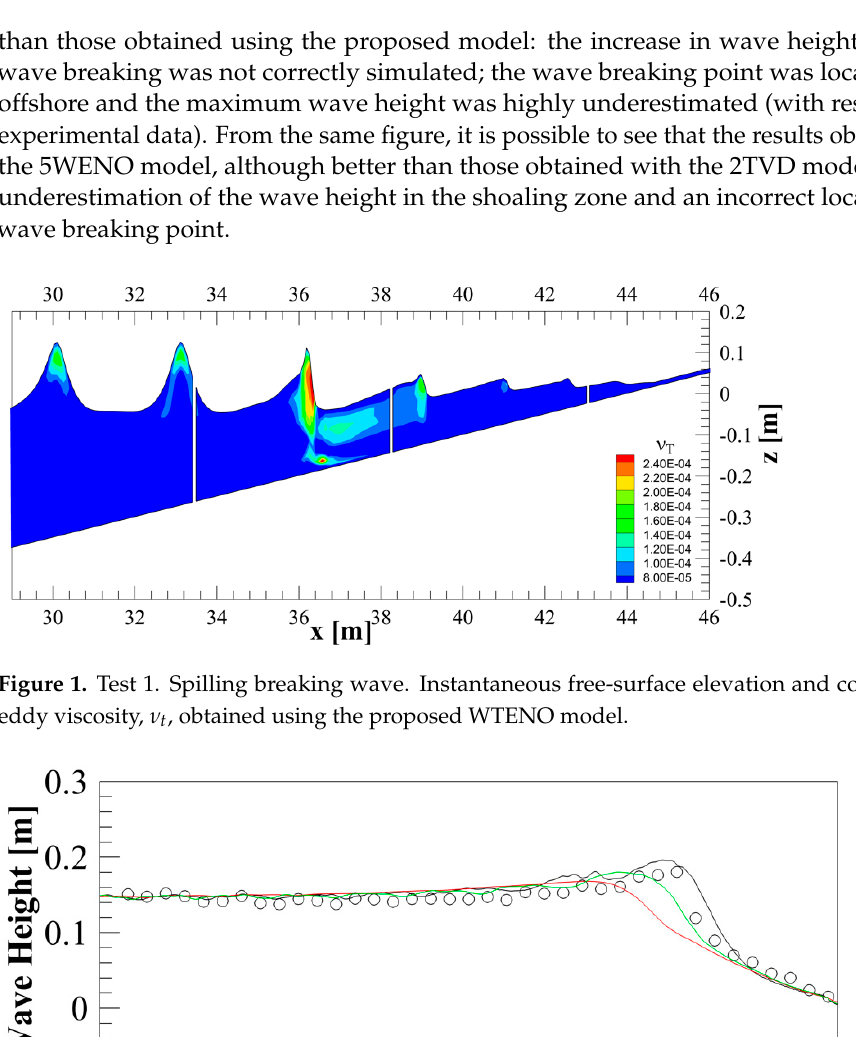
Figure 1. Test 1. Spilling breaking wave. Instantaneous free ‐ surface elevation and contour of the eddy viscosity, 𝜈 (cid:3047) , obtained using the proposed WTENO model.